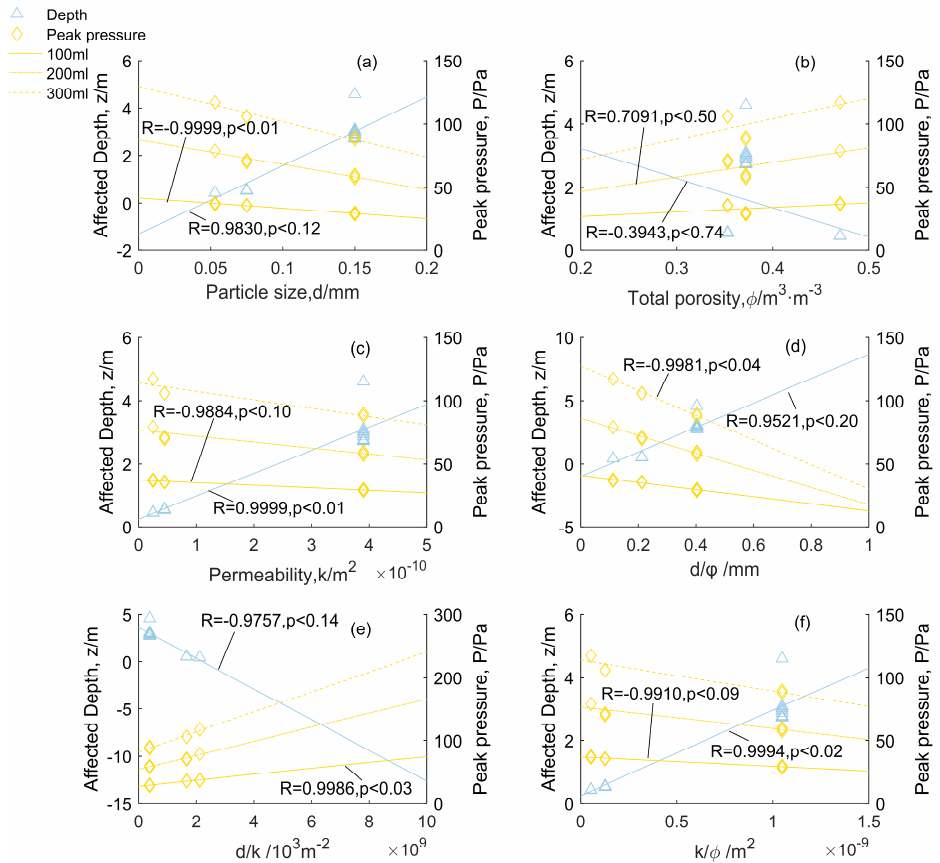
Figure 11. Different soil physical properties and their relationships with the depth up to which pressure difference can influence them and initial peak pressure difference: ( a ) soil particle size; ( b ) total soil porosity; ( c ) soil pore permeability; ( d ) ratio of particle size to porosity; ( e ) ratio of particle size to permeability; ( f ) ratio of permeability to porosity. All correlation coefficients in the figure were considered as the best values.